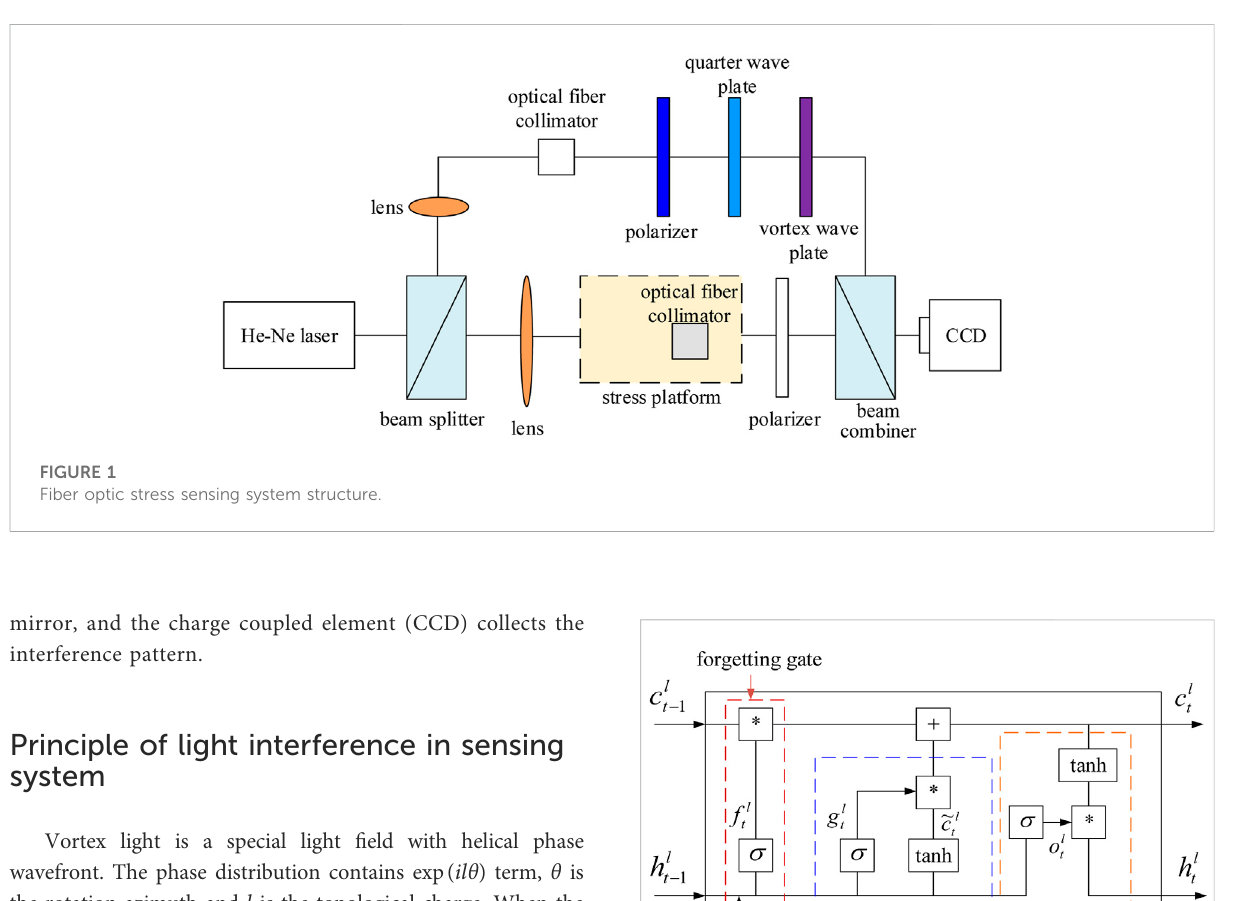
FIGURE 2 Cell structure of